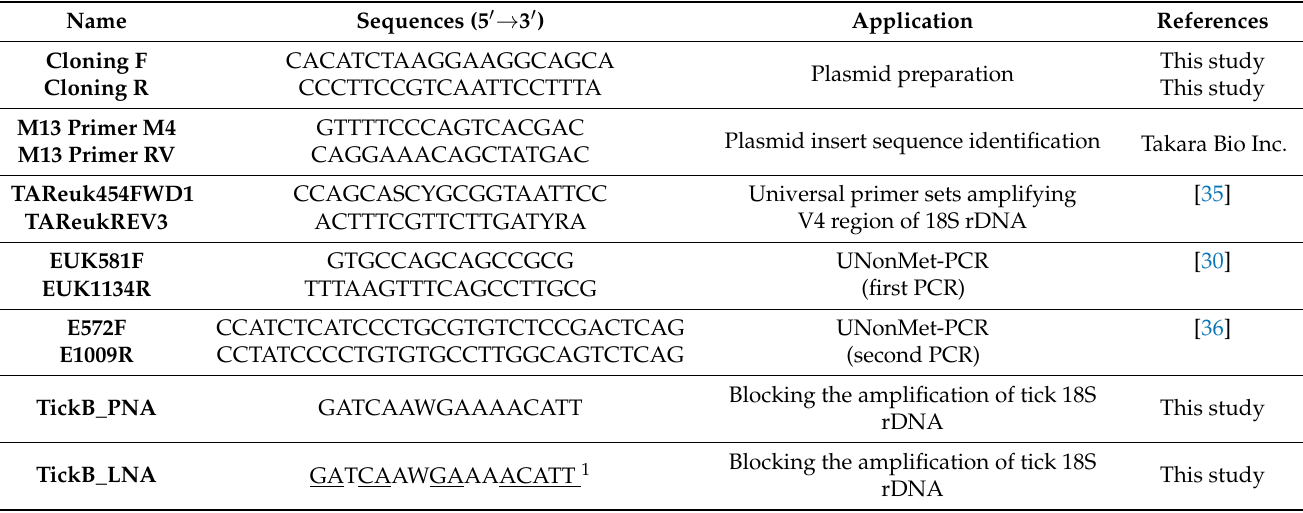
Table 2. Primers and blockers used in this